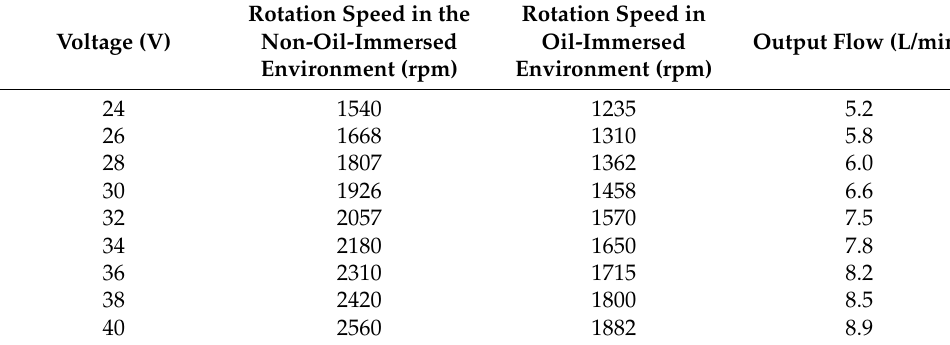
Figure 9. The test bench of the proposed IEHVP. Table 1. The influence of oil on motor Table 1. The influence of oil on motor speed.